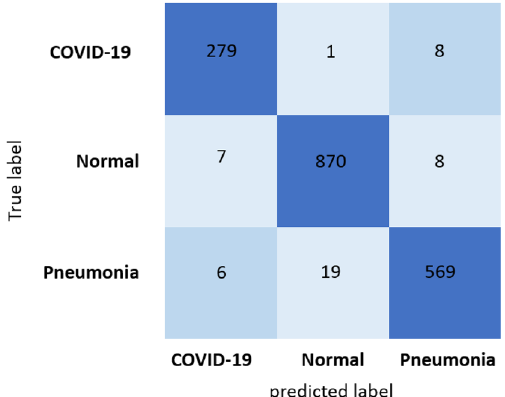
Figure 5. Confusion matrix of our proposed model: The dark-blue boxes illustrates the true prediction, and the light-blue boxes illustrates the false prediction.